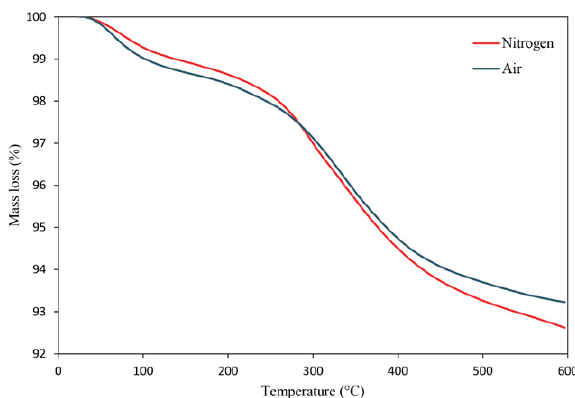
Figure 1: Mass loss of γ-Fe 2 O 3 -NH 4 OH@SiO 2 (APTMS) in N 2 and air atmosphere